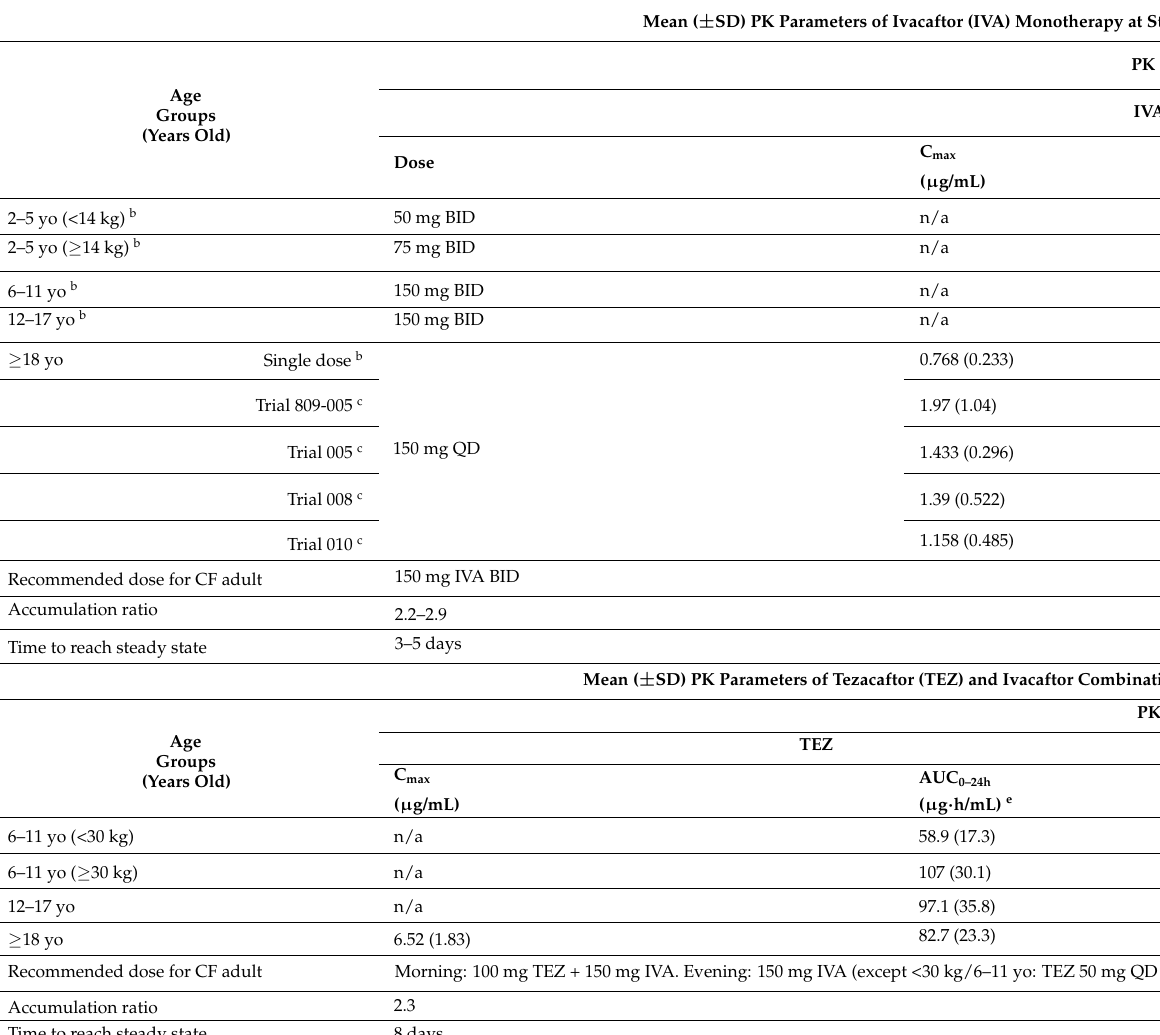
Table 2. CFTR modulator exposure according to labeling information for the four current CF